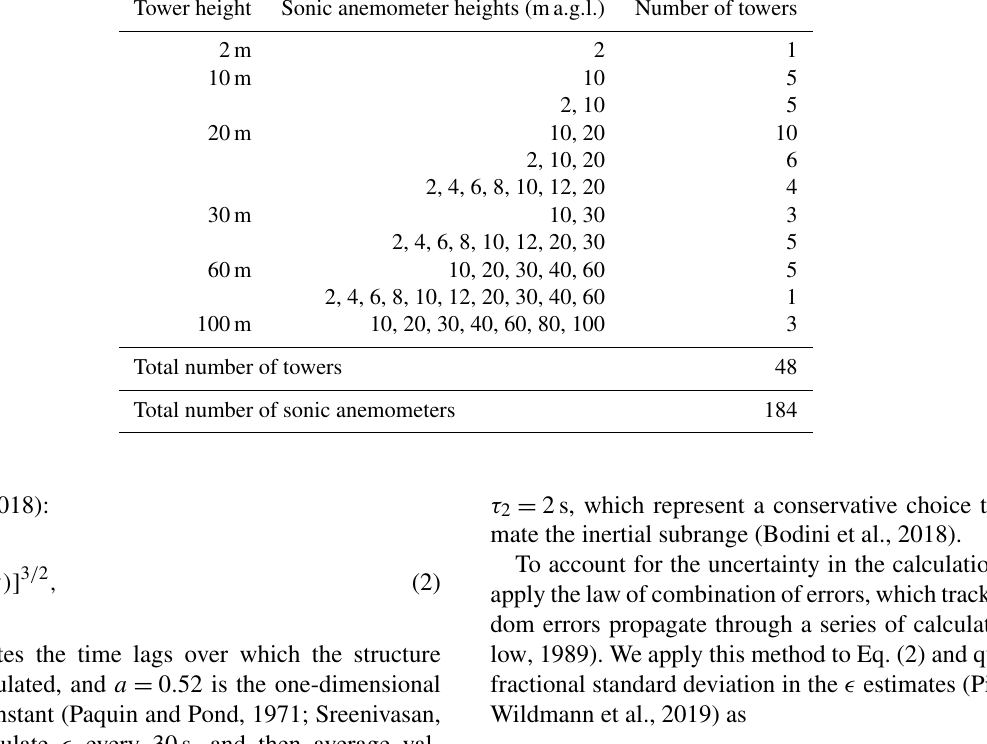
Figure 1. Map of the Perdigão valley showing the location and height of the 48 meteorological towers whose data are used in this study. Digital elevation model data are courtesy of the US Geological Survey. Table 1. Heights where sonic anemometers were mounted on the meteorological towers at the Perdigão field campaign. Tower height Sonic anemometer heights (ma.g.l.) Number of